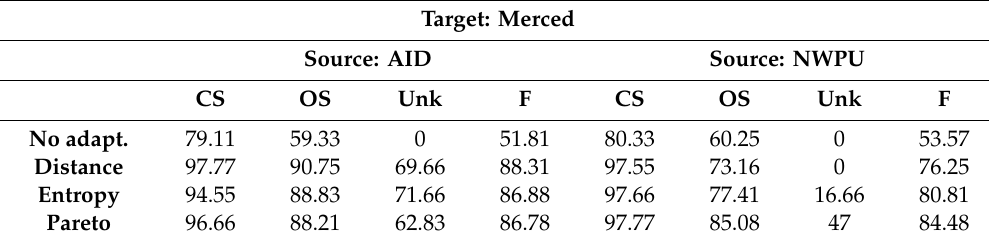
Table 1. Classification results obtained for the scenarios: AID → Merced and NWPU → Merced for an openness = 25%.